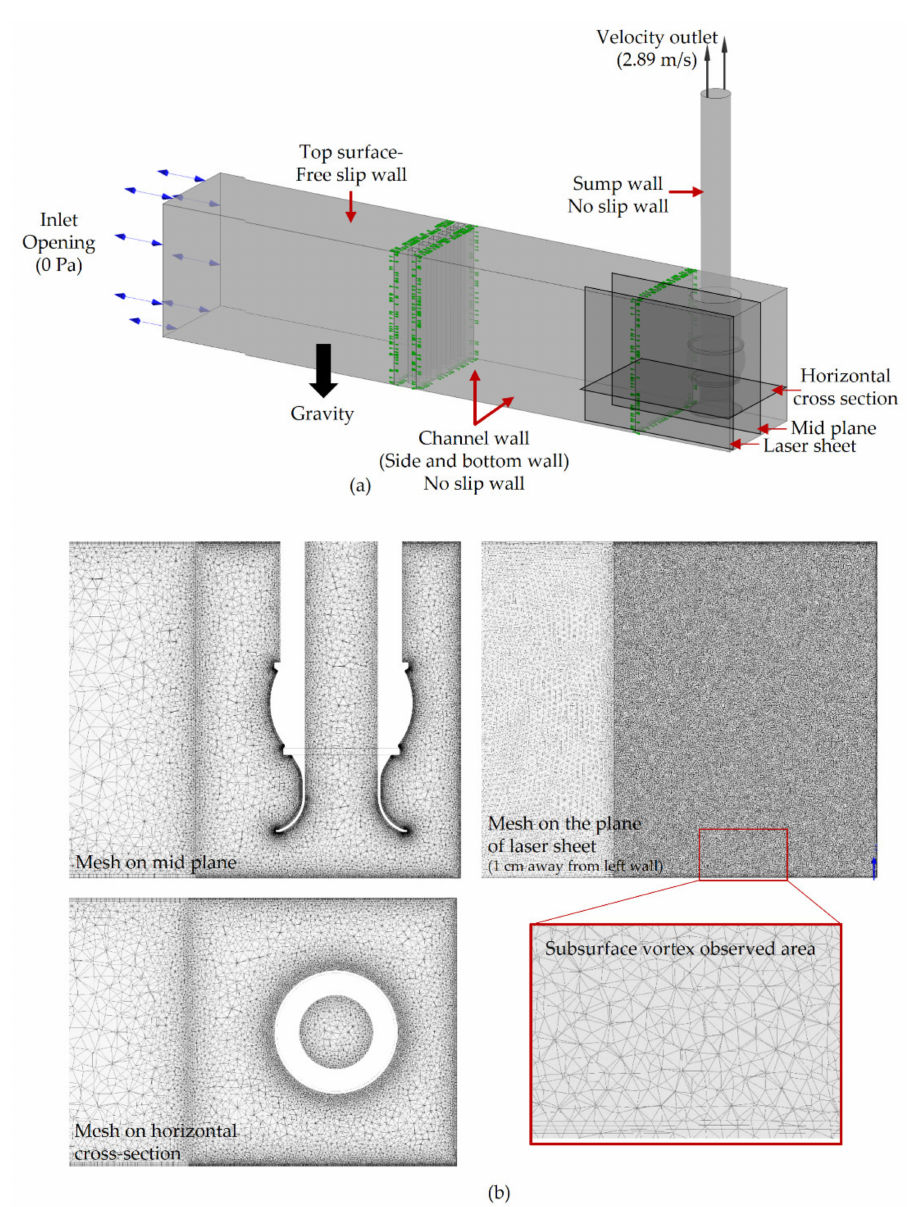
Figure 6. Fluid domains for CFD analysis: ( a ) CFD set up; ( b )